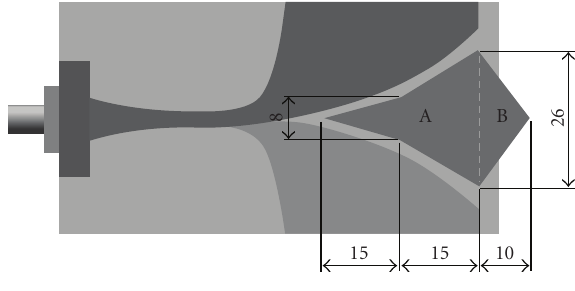
Figure 3: BAVA-D with shape and dimensions of director. The director is made of a dielectric with relative permittivity of 6.